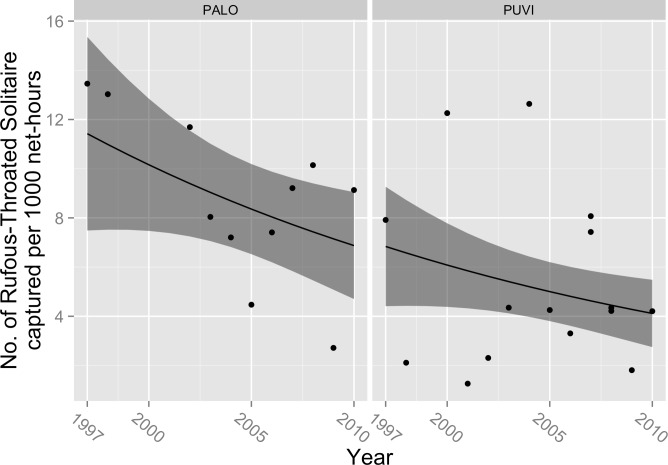
Trends in capture rate of Rufous-throated Solitaire (Myadestes genibarbis).Observed capture rate (dots) of Rufous-throated Solitaire and changes in expected capture rate (solid line; shaded area = 95% confidence interval) per 1,000 net-hours at two sites (PALO, Palo de Agua; PUVI, Pueblo Viejo) in montane broadleaf forest of Sierra de Bahoruco, Dominican Republic.